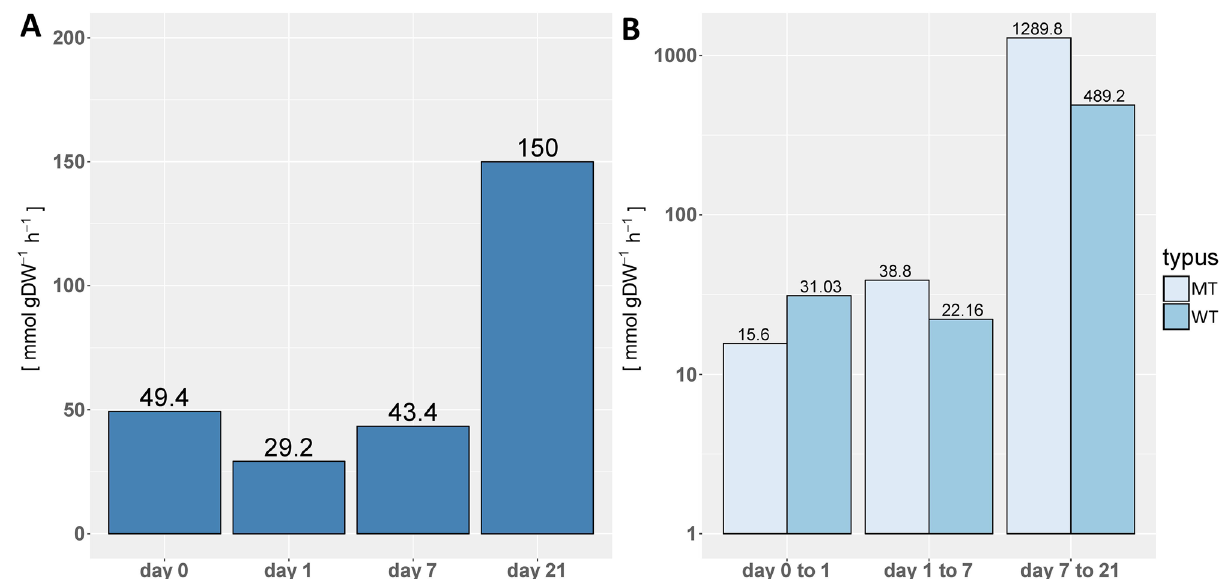
Figure 2. Changes in predicted sum of Fluxes. Shown are the optimal values of the Euclidean distance (displayed on y-axis) at each corresponding time point or time step (displayed on x-axis). Distances were visualized by plotting the Euclidean distance value above each bar. ( A ) Displayed are the sums of flux difference between wild type and mutant at each corresponding time point. ( B ) Displayed are the sums of flux differences between wild type fluxes and mutant fluxes between each two time consecutive